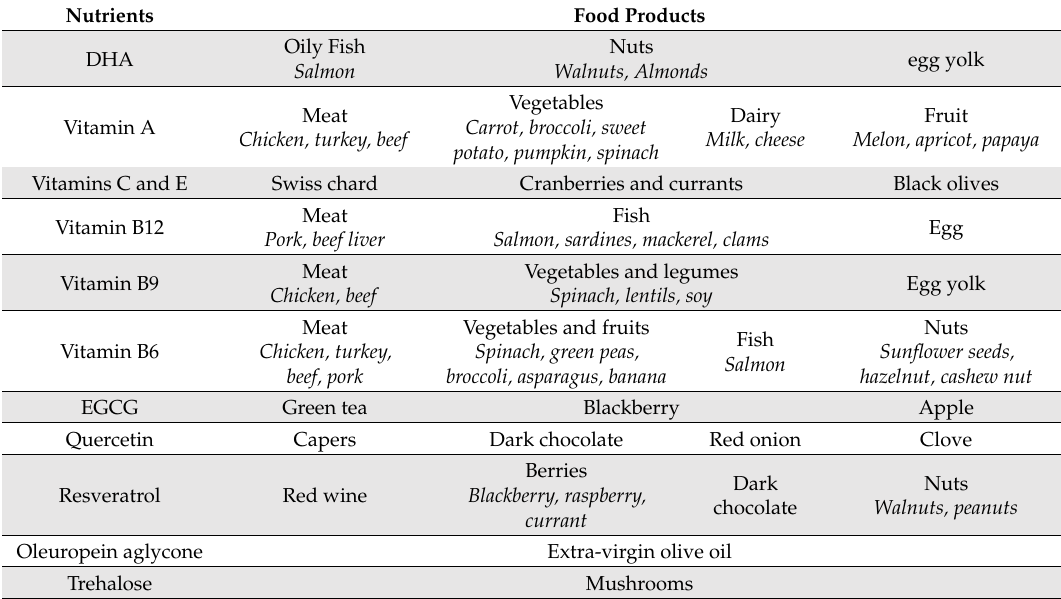
Table 1. Nutrient-rich food products for those nutrients that may intervene in Alzheimer’s